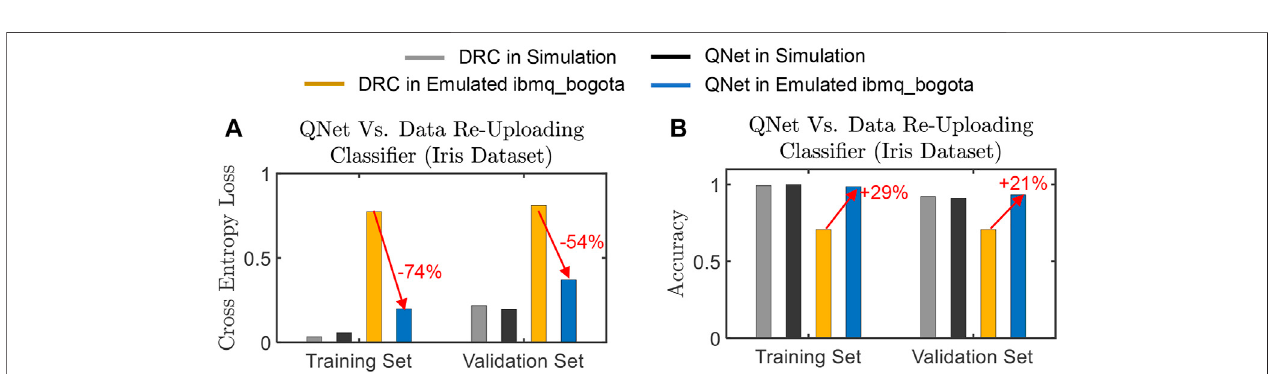
FIGURE 10 | Performance comparison between QNet and DRC on Iris classi fi cation dataset. We report (A) loss and (B) accuracy of the trained QNet and DRC models in noiseless simulation and emulated hardware (ibmq_bogota). In the noiseless simulation, their performances are comparable. However, under noise, QNet signi fi cantlyoutperformsDRC.ForQNet,weusedQQ (cid:2) 2,PL (cid:2) 2,QL (cid:2) 2.Forafaircomparison,wevarythenumberoftrainableparametersinasingle-qubitDRCmodel and report the best-measured performance against